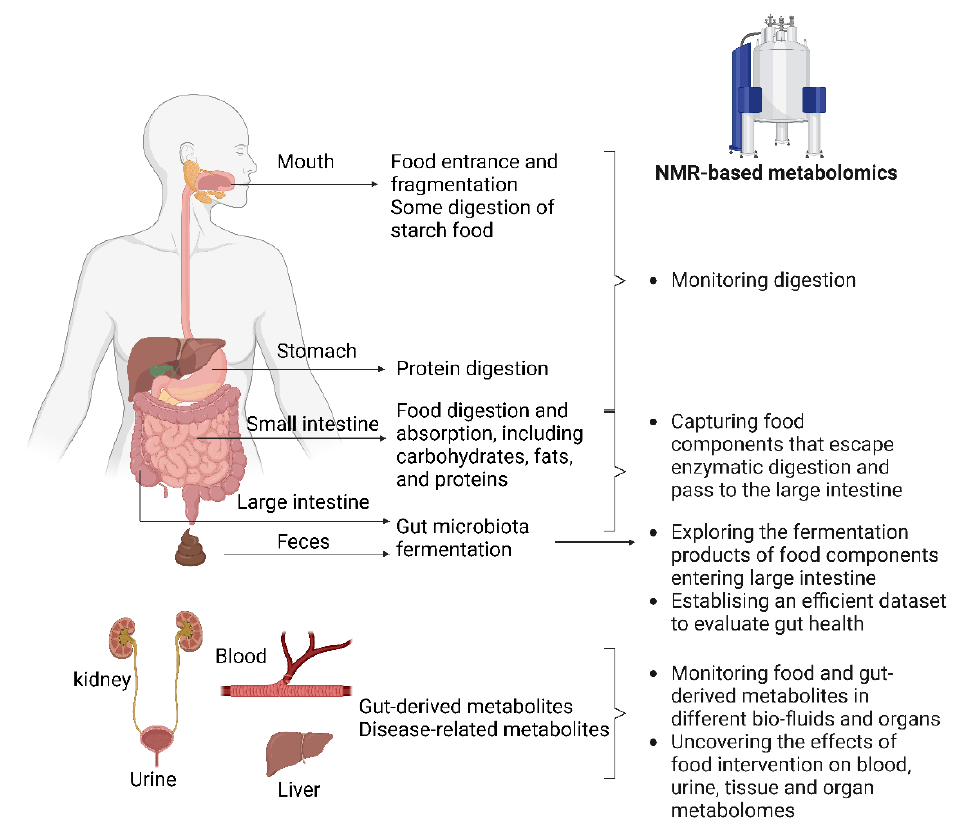
Figure 1. Multiple purposes of NMR-based metabolomics through analysis of samples collected from different sites of gastrointestinal contents, bio-fluids, tissues, and organs. Figure created with Biorender.com